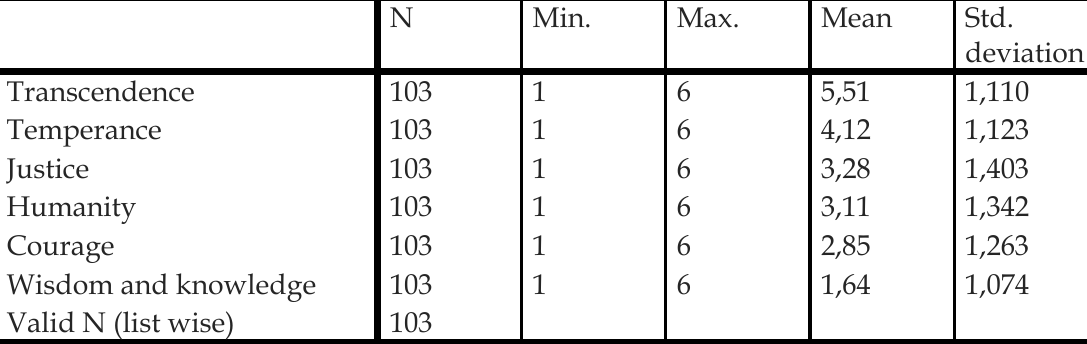
Table 1. Importance of virtues in the perception of Polish students Source: Own analysis